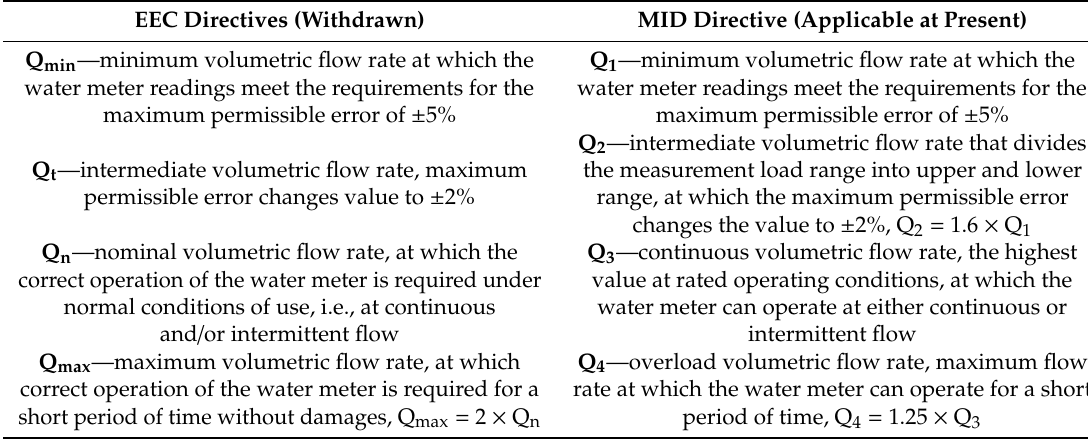
Table 1. Comparison of volumetric flow rates for water meters manufactured according to the EEC and Measuring Instruments Directive (MID)